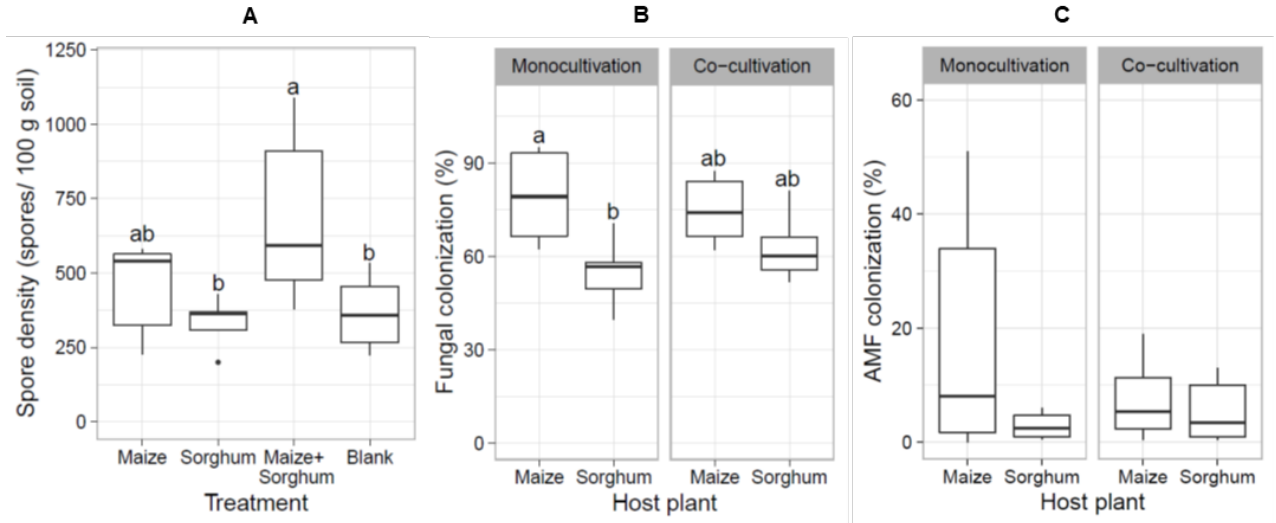
Figure 5. AMF spore density and root length colonization by fungi and AMF after the second trap culture. The box plots show the distribution of AMF spore density in mono-cultivation trap cultures containing maize or sorghum; a co-cultivation trap culture containing maize and sorghum; and a trap culture without host plants as a blank ( A ); fungal colonization ( B ); and AMF colonization ( C ) in roots from each treatment ( n = 6 biological replicates). Statistical analysis was performed by one-way ANOVA following LSD. Different letters indicate significant differences ( p < 0.05). Table 2. Comparison of T-RF components in trap culture under different host plants. Comparison was performed by pairwise PERMANOVA of Jaccard